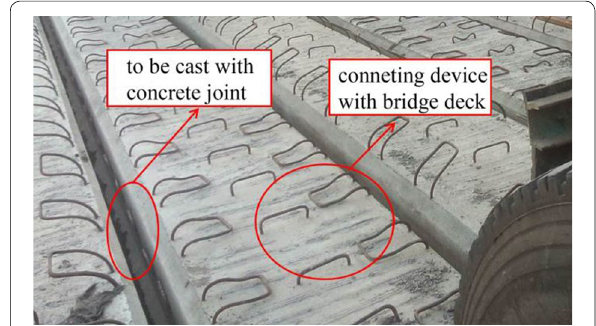
Fig. 2 Connection configuration of the bridge superstructure.